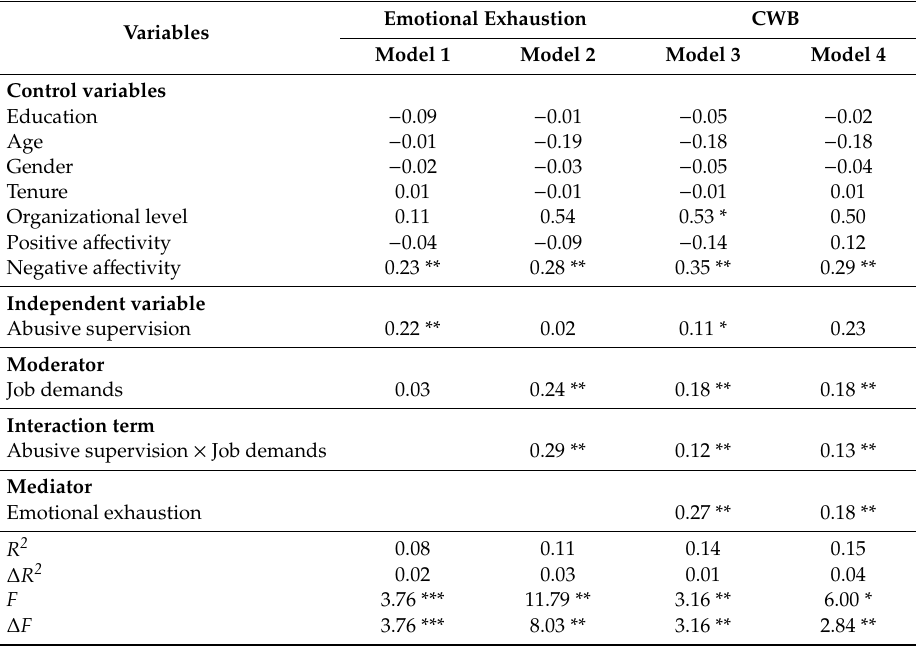
Table 3. Results of hypotheses